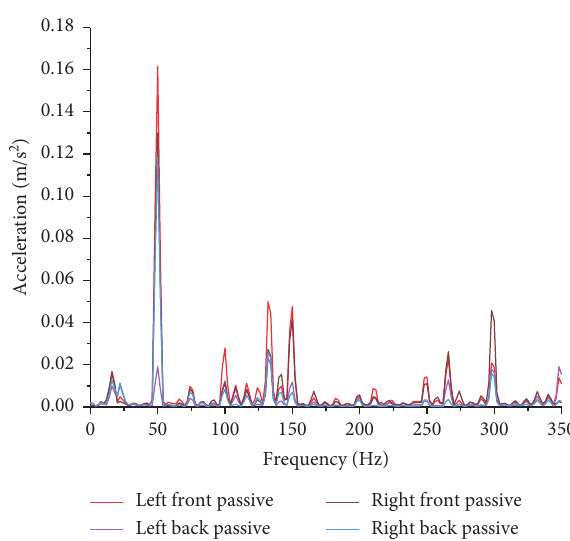
Figure 7: Acceleration excitation at 1050rpm.